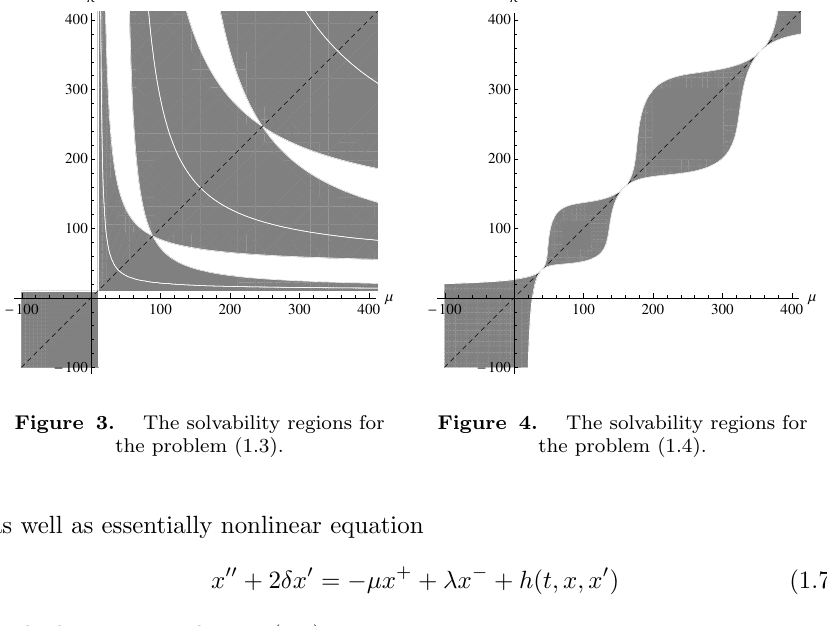
Figure 4. The solvability regions for the problem